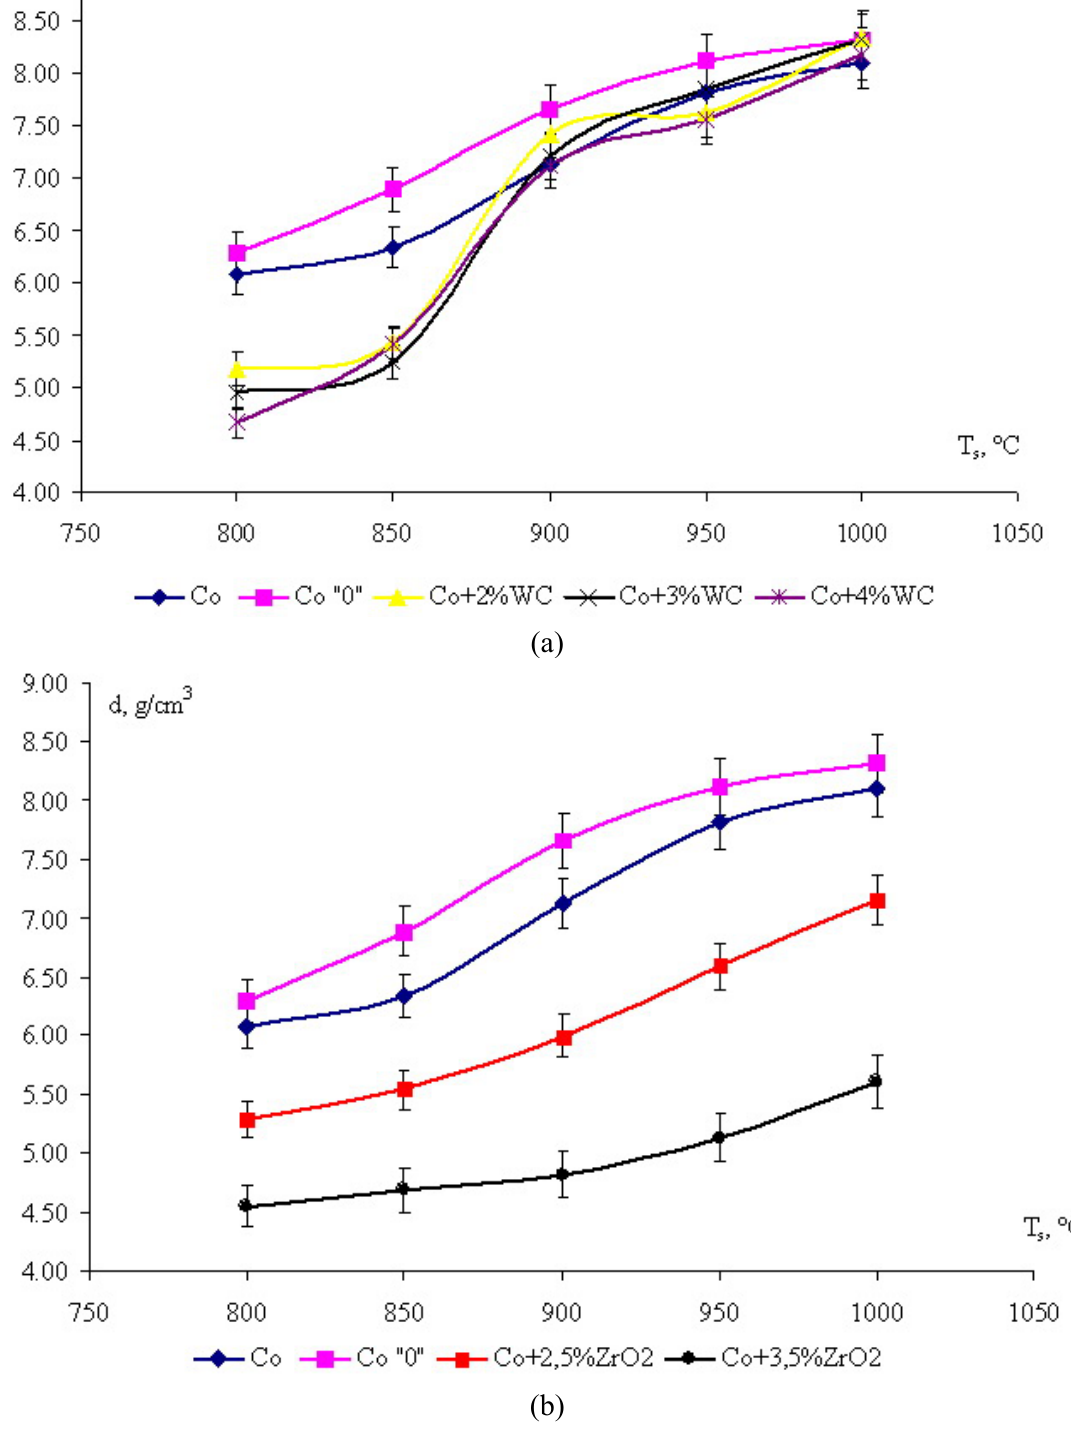
Figure 6. Sintering curves for (a) Co–WC nano and (b) Co–ZrO 2nano mixtures ( t